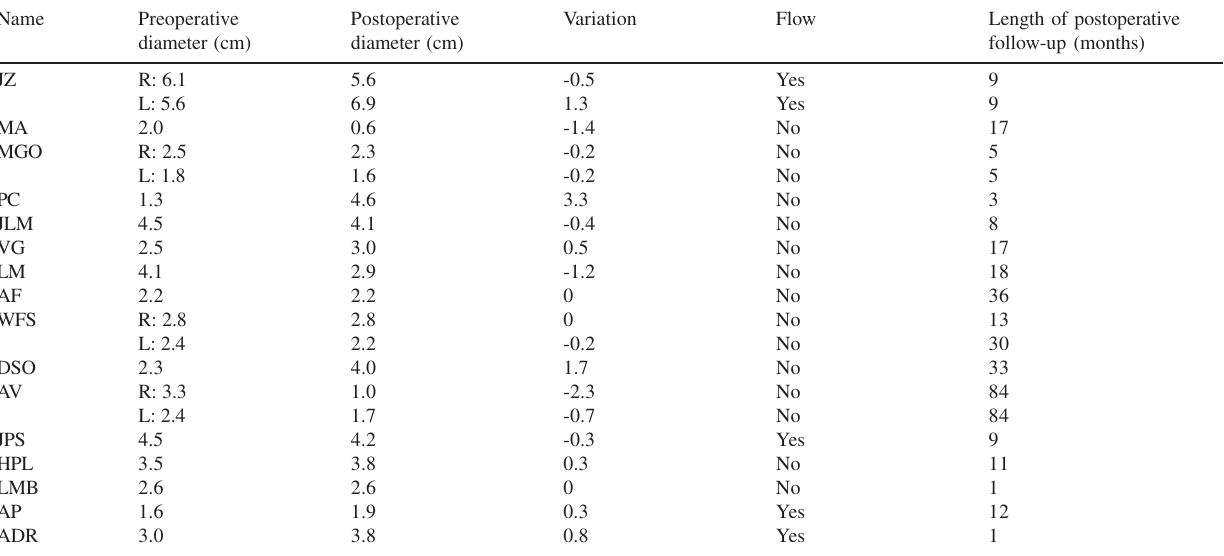
Table 2 - Diameter variation and intrasac flow detection by duplex scanning Name